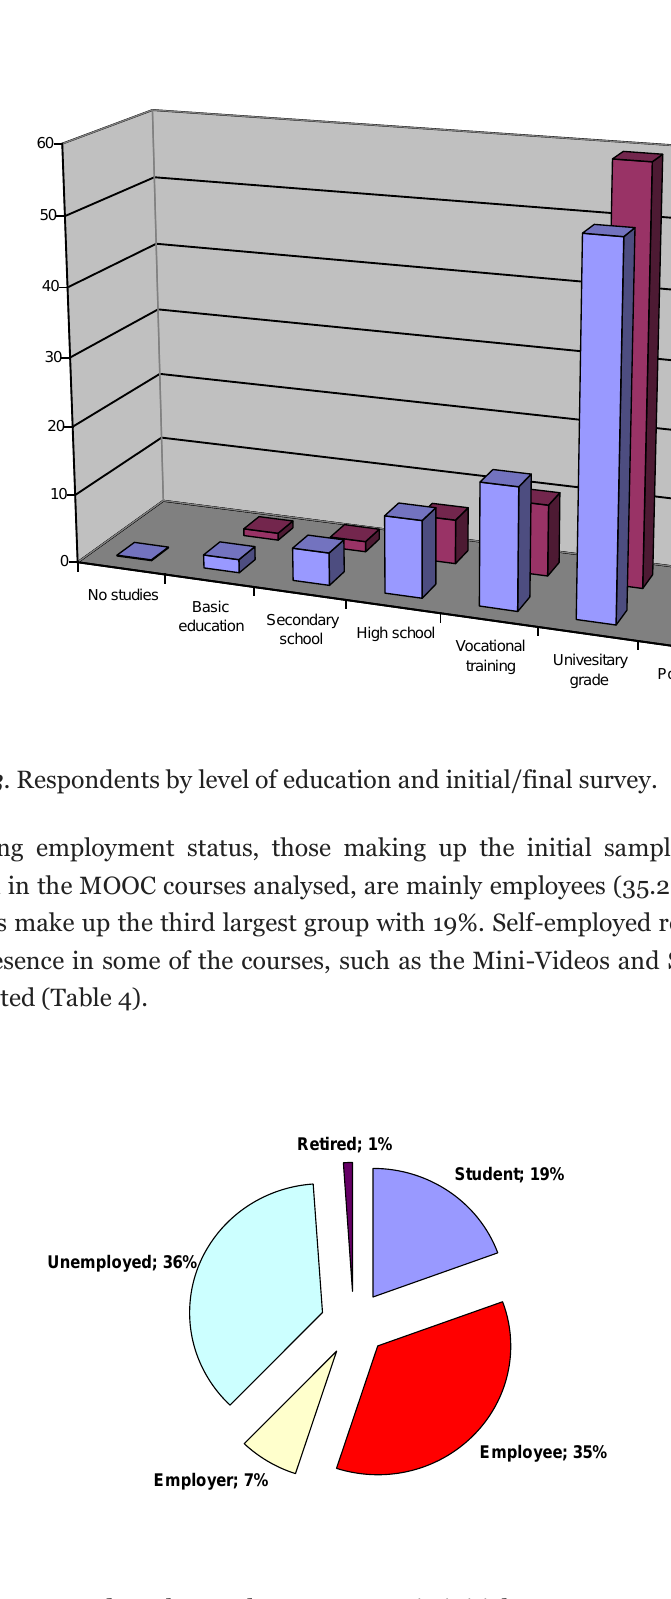
Figure 4 . Respondents by employment status in initial